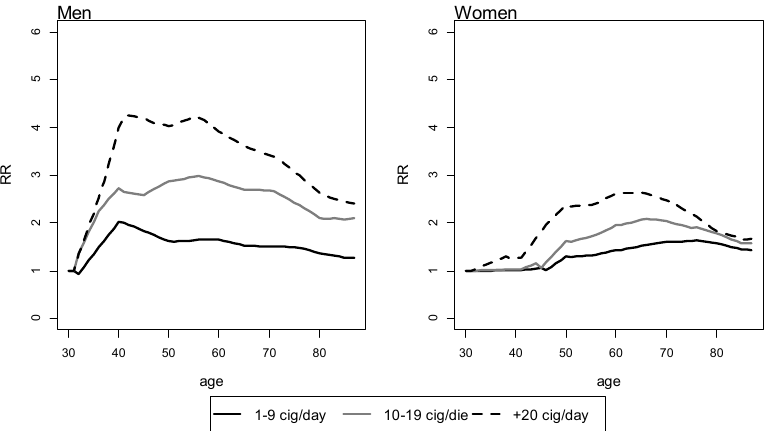
Figure 1. Relative risks of death for current smokers by number of cigarettes smoked per day and